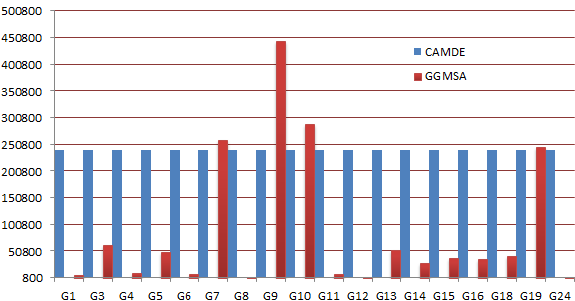
Figure 5. The number of “wins-draws-losses” of GHMSA compared with other algorithms for G01 to G24 and Enp1 to Enp4.